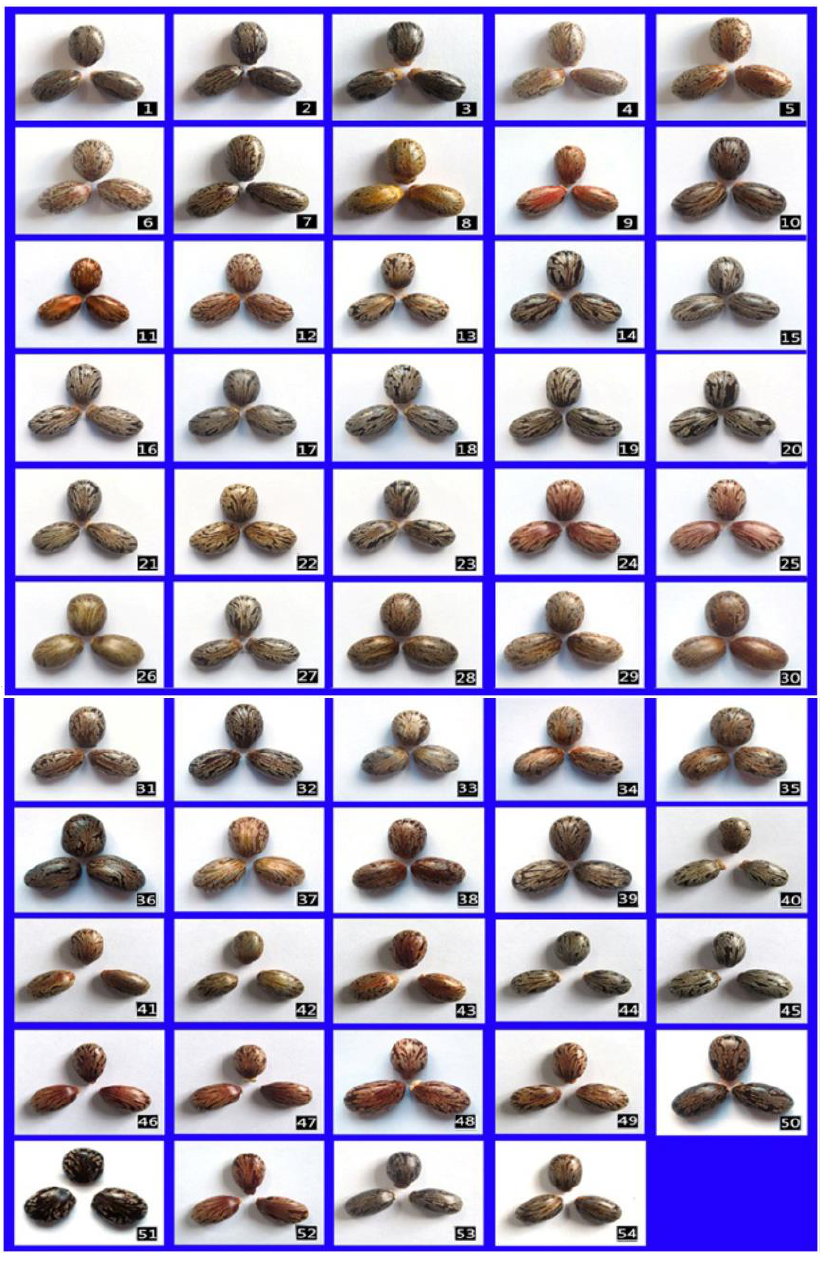
Figure 1. The seed patterns of 54 R. communis L . samples were collected from different locations in the world. See Table 1 for abbreviations of the varieties.